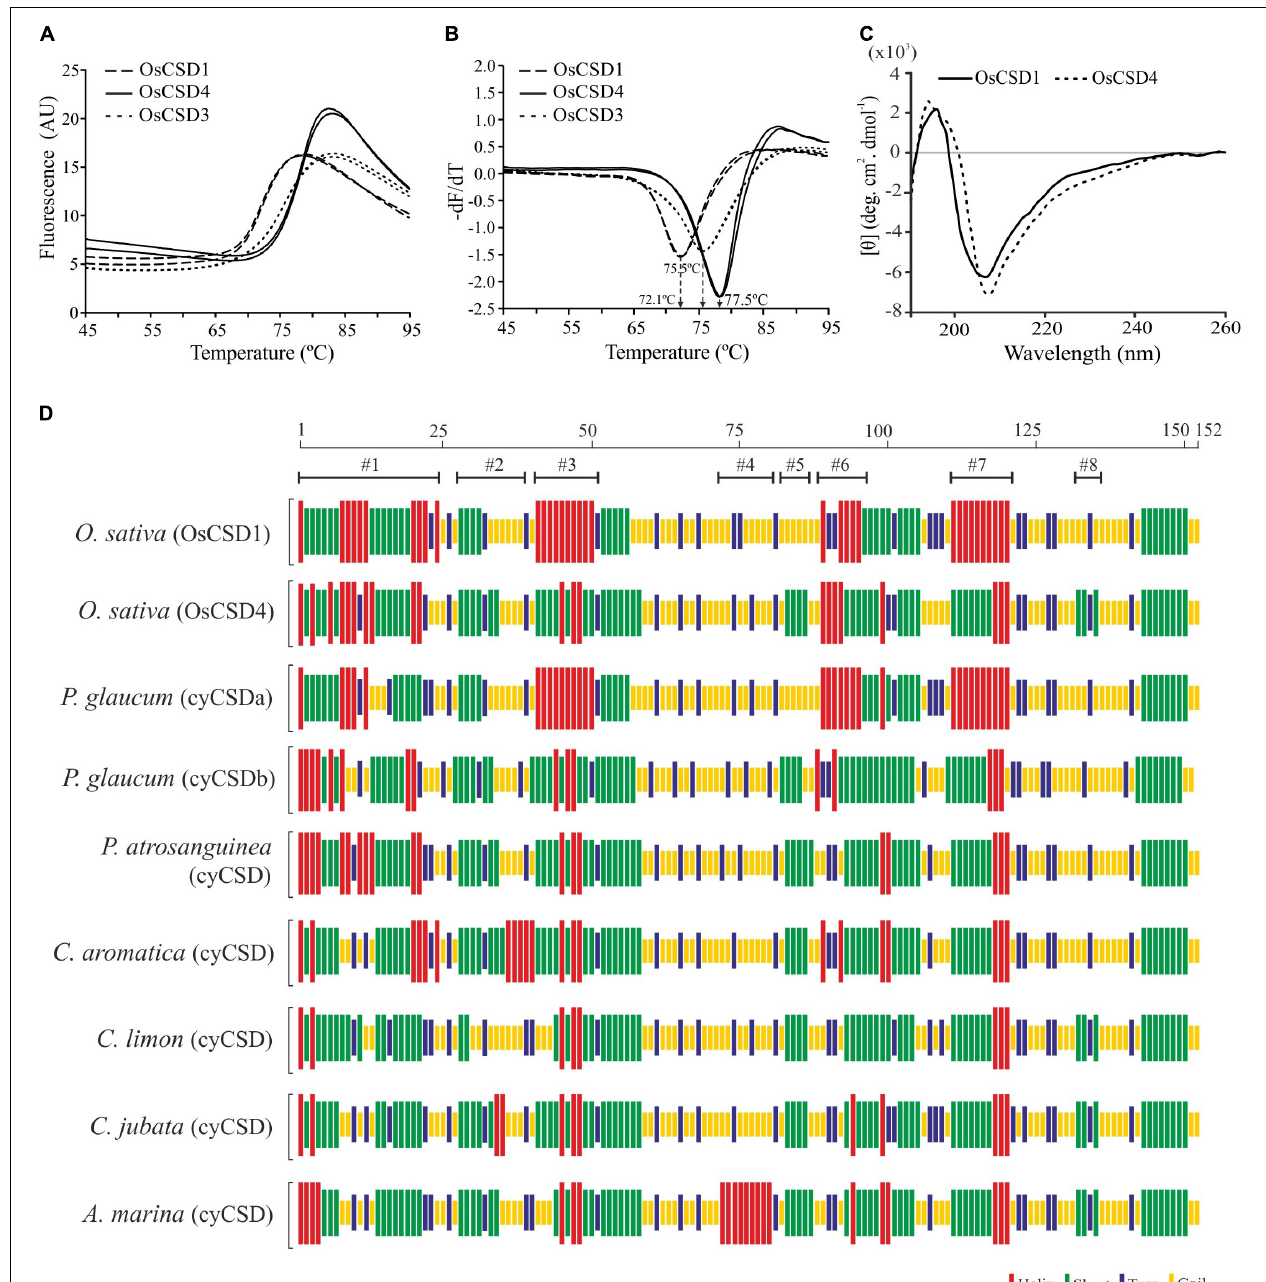
FIGURE 6 | Differential scanning fluorimetry (DSF) and secondary structure analysis. (A) DSF profiles of OsCSD1, OsCSD4, and OsCSD3 generated using a Roche LightCycler LC480 II real-time PCR system. (B) First derivative curve (-dF/dT vs. Temperature) generated using the Tm calling software function for estimation of melting temperature (Tm) of respective OsCSDs, as indicated by arrows. (C) Circular dichroism spectra of OsCSD1 and OsCSD4 (parameters, path length: 0.5 cm, Acq duration: 0.2 s, and band width: 2.0 nm). (D) Analysis of plant cytosolic CSDs (cyCSDs) of Oryza sativa (OsCSD1 and OsCSD4, this study), P . glaucum (cyCSDa, ABP65325, Mahanty et al., 2012), P . glaucum (cyCSDb, this study), P . atrosanguinea (EU532614, Kumar et al., 2012), C . aromatica (FJ5896638, Kumar et al., 2014), C . limon (AF318938, Lin et al., 2002), C . jubata (EF530044, Kumar et al., 2016b), and A . marina (ACA50531.1, Fesharaki-Esfahani et al., 2021) by the CFSSP online tool. The scale on the top indicates the position of amino acids while #1-#8 indicate the regions affected with substitutions.